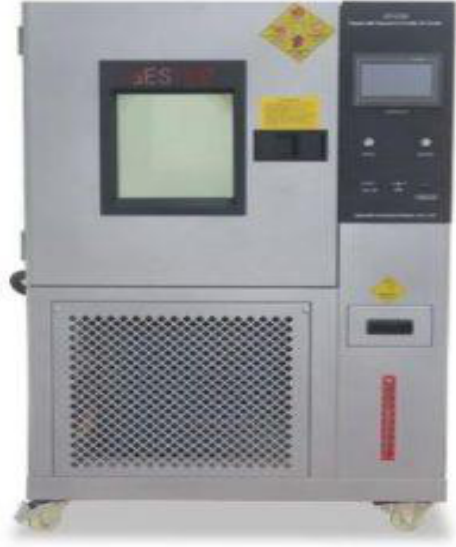
Figure 2. Short-term hydrothermal aging setup.